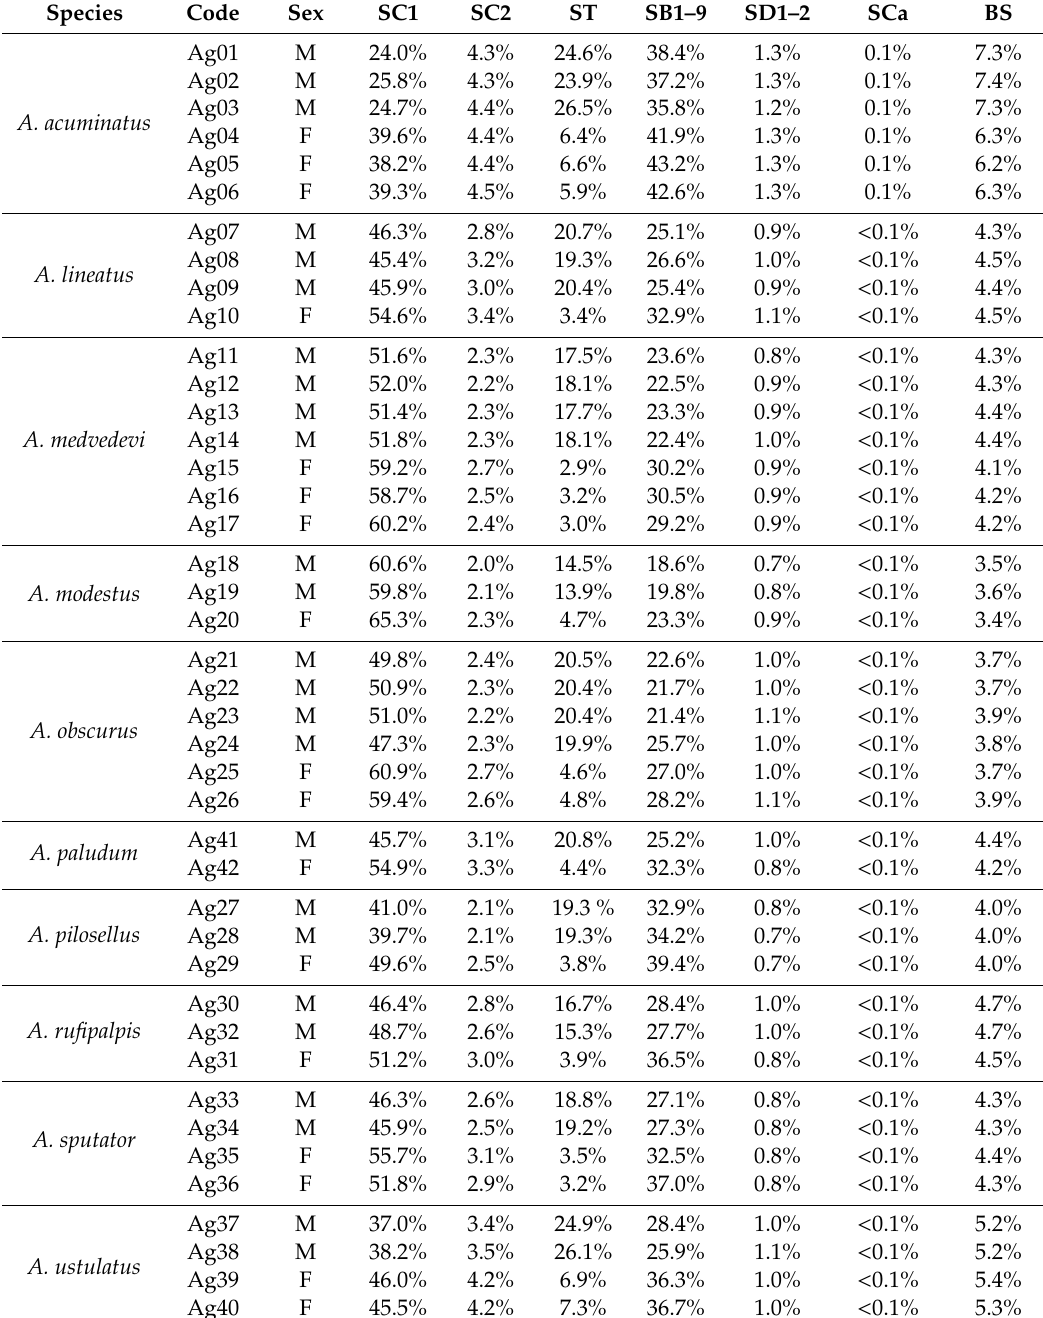
Table 4. Percentages of di ff erent sensillum types within the individual specimens of all examined Agriotes species. M, male; F, female; SC1 and SC2, sensilla chaetica subtypes 1 and 2, respectively; ST, sensilla trichodea; SB1–9, sensilla basiconica subtypes 1–9; SD1–2, dome-shaped sensilla subtypes